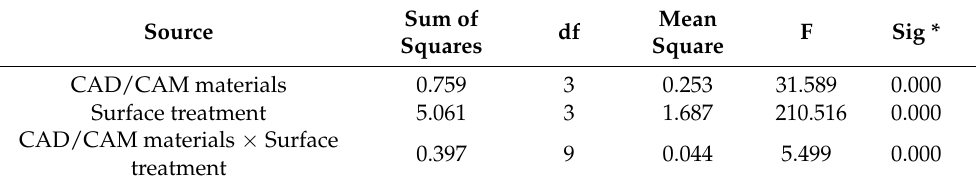
Mean Sum of F Sig * df Square Squares 0.397